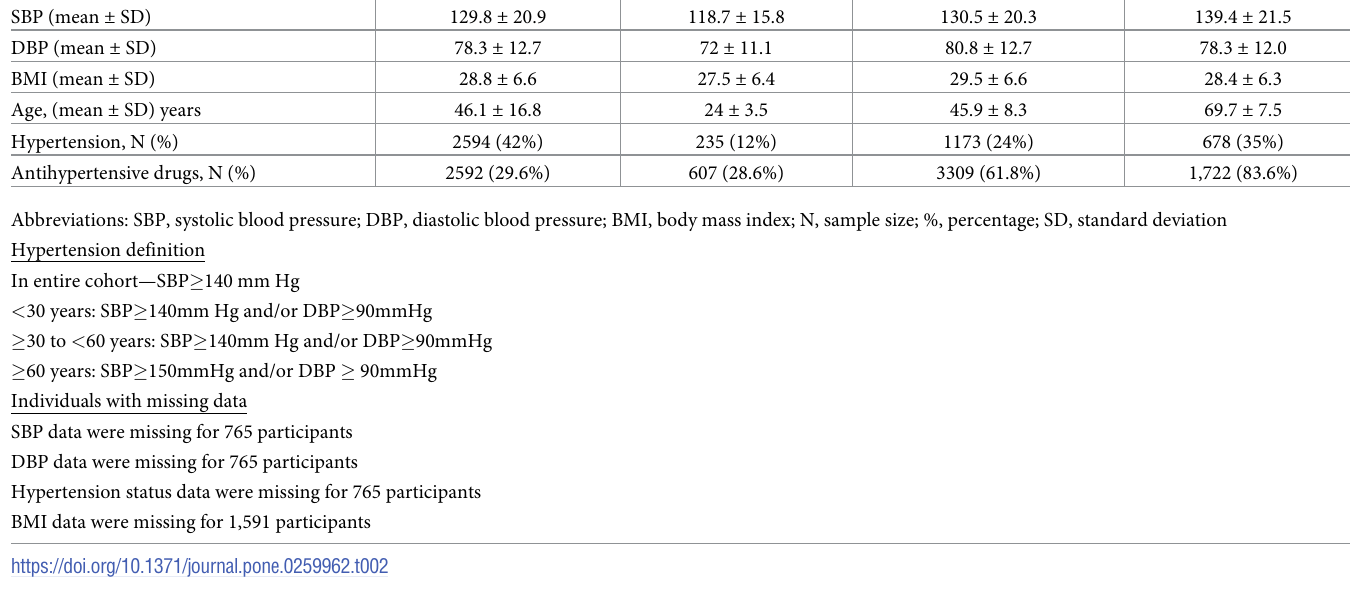
( Table 2 ). Following the JNC-8 guidelines, breakdowns by age strata show the expected trend of increasing SBP, DBP, and hypertension prevalence with age. We identified 14 SNPs previously associated with hypertension in European-ancestry pop- ulations that were also genotyped on the Metabochip and available for analysis in our dataset. We observed similar allele frequencies between our study population and the African (AFR) samples from the 1,000 Genomes Project, but notable differences in frequencies of these SNPs in other populations (American, Asian and European) does exist ( Table 1 ). We replicated one known European hypertension association to genetic variants in our AA cohort and observed two borderline associations. We defined criteria for hypertension according to two guidelines,